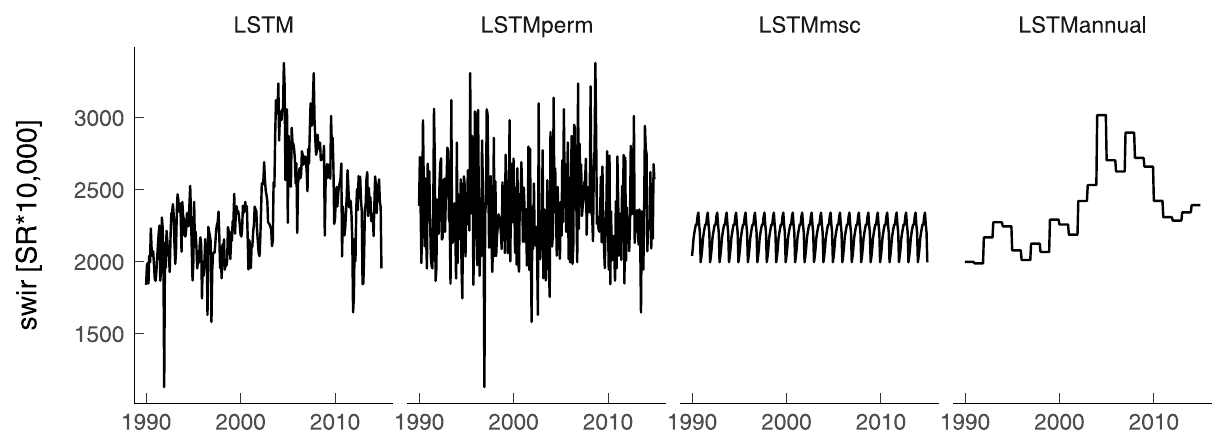
Fig 3. Illustration of the different Landsat time series temporal architectures of the different LSTM model set-ups for the SWIR band only for the period 1990-2015. SWIR = Short Wave Infrared. SR = Surface Reflectance. The US-SO3 site where fire followed by regrowth was reported in 2003 is